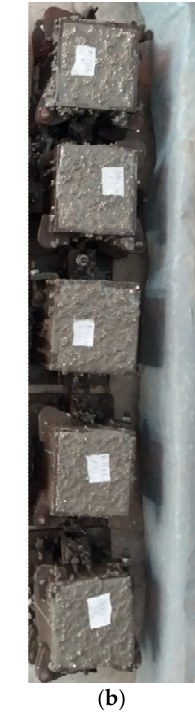
Figure 4. View of concrete samples: ( a ) cubic shape concrete samples, ( b ) plate shape concrete samples.